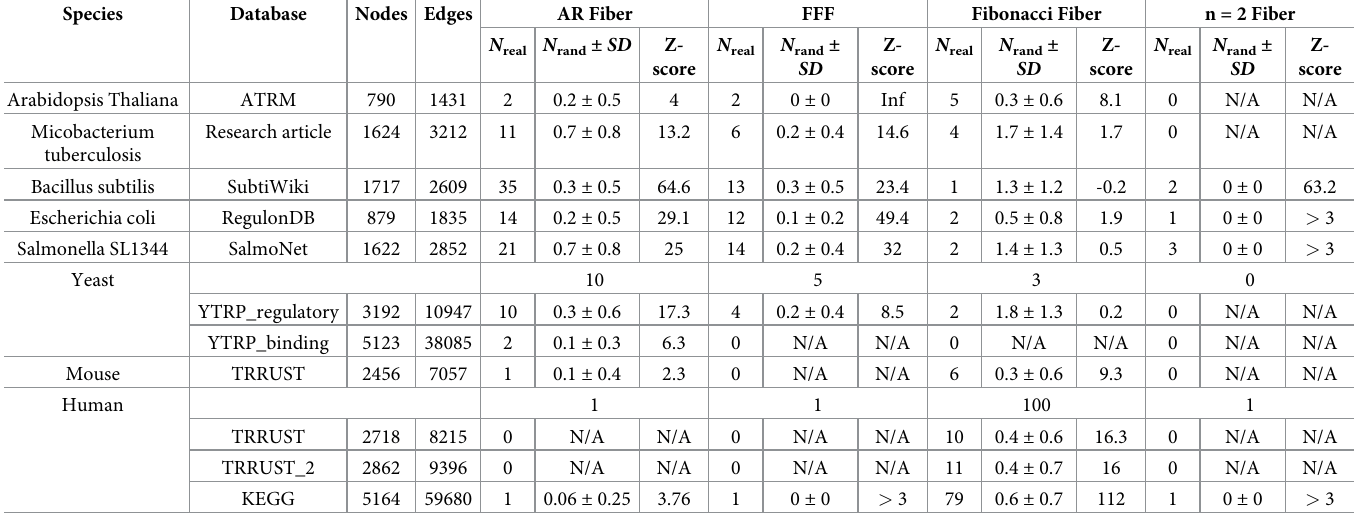
Table 1. Symmetric circuits ( fibers ) count